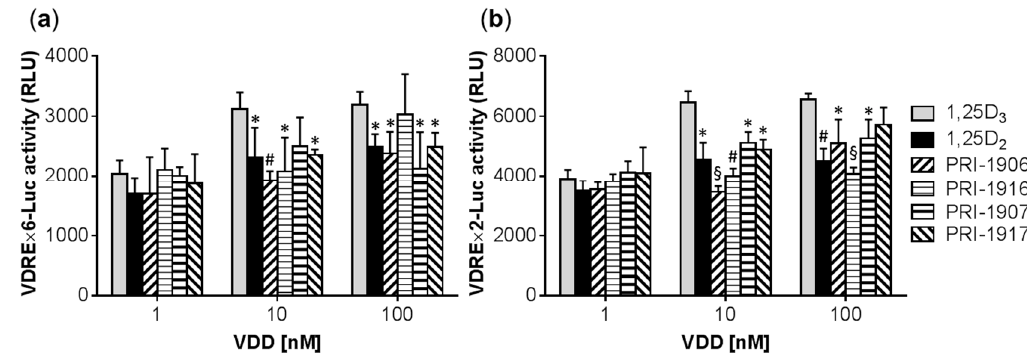
Figure 4. Vitamin D 2 derivatives are less effective than 1,25D3 in transactivating vitamin D response element (VDRE). U937 cells were transiently co-transfected with VDRE×6-Luc ( a ) or VDRE×2-Luc ( b ) and Renilla luciferase constructs, and incubated with the indicated agents for 24 h. The relative firefly luciferase activity (means ± SD) was calculated from the data of 3 individual experiments performed in quadruplicate. The basal VDRE activity, in the absence of vitamin D derivatives (VDDs), was negligible (50–100 RLU) for both VDRE reporter constructs. *, p < 0.05; # , p < 0.01; and § , p < 0.001 vs. 1,25D3 at each concentration of the VDDs.